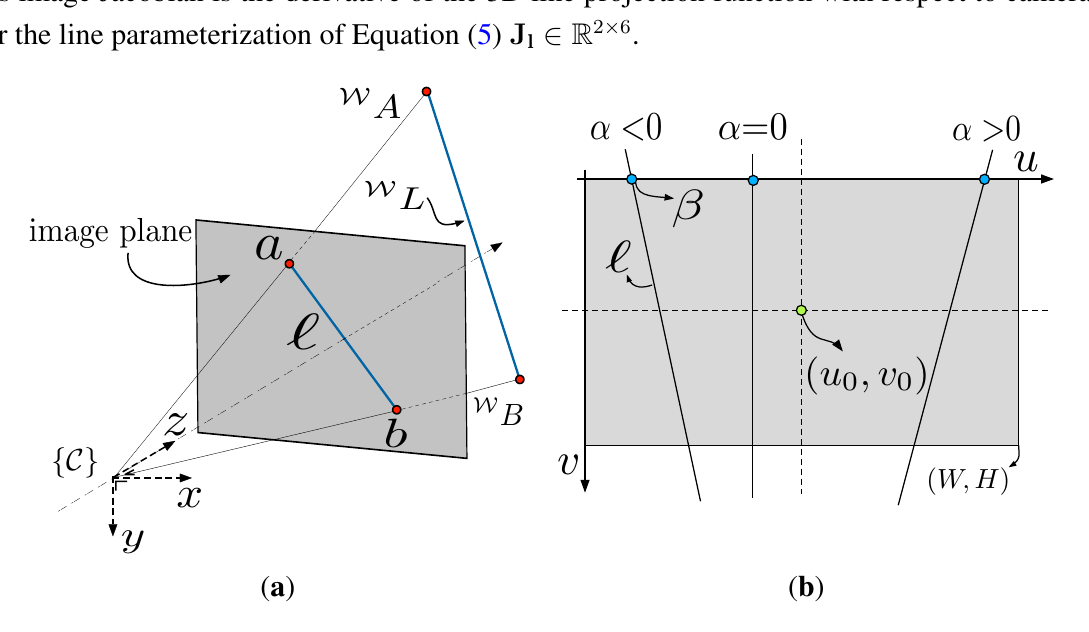
Figure 3. ( a ) Perspective image of a line W L in 3D space. a and b are projections of the world point and (cid:96) is a line on the image plane; ( b ) Image plane representation of slope ( α ) and intercept ( β